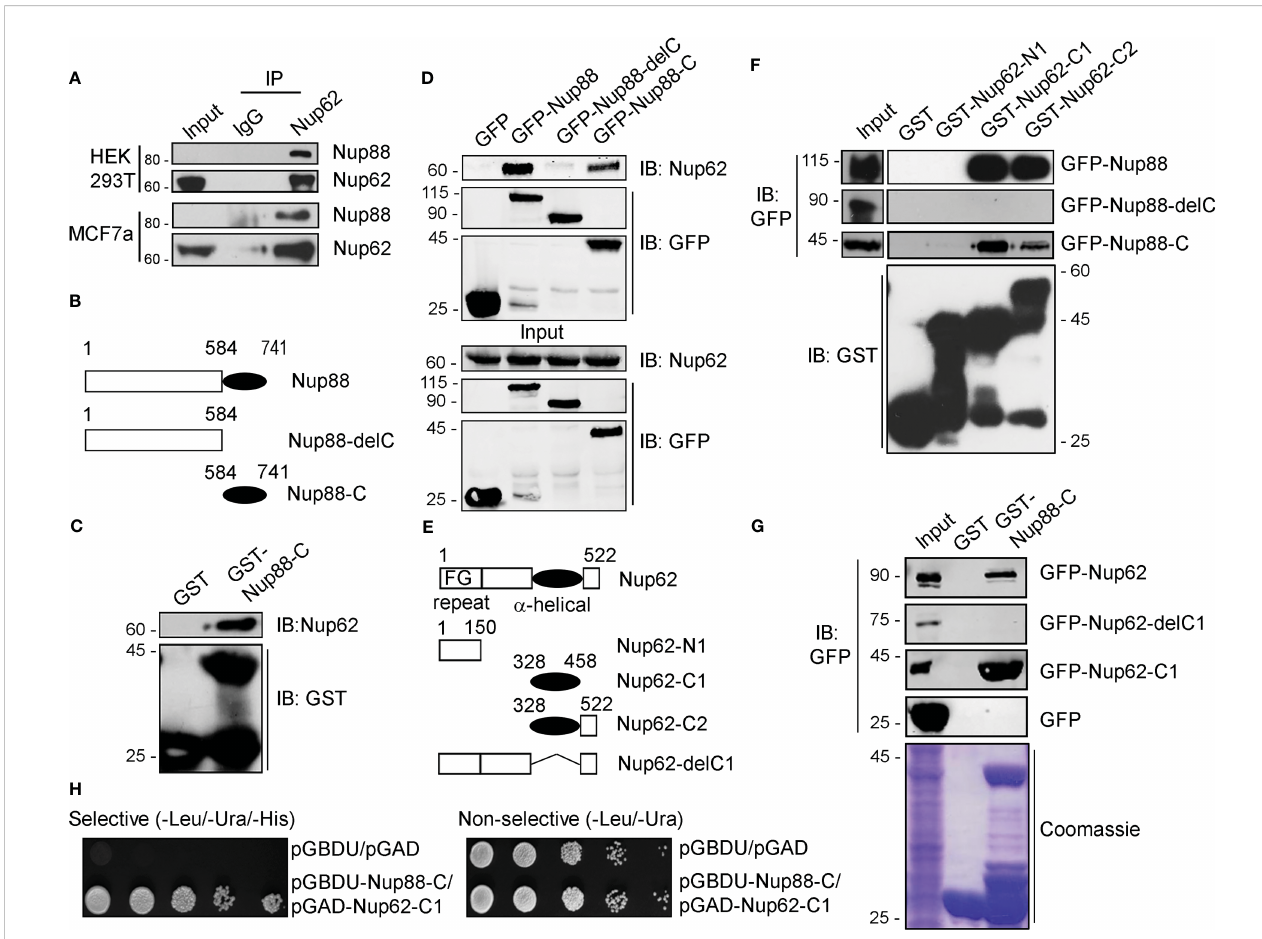
FIGURE 3 Nup88 and Nup62 interact through their carboxy-termini. (A) Anti-Nup62 antibody-mediated immunoprecipitation (IP) from HEK293T and MCF7 cell lysates and immunoblotting (IB) for indicated proteins. (B) Schematic representation of Nup88 domain constructs used in cellular transfection and GST and GFP binding protein (GBP) pulldown experiments. (C) Pull down of endogenous Nup62 on GST and GST-Nup88-C coated beads from HEK293T lysates and detection by indicated antibodies. (D) GBP pulldown from HEK293T lysates expressing either GFP-Nup88 or GFP-Nup88-delC or GFP- Nup88-C. Pulldown and input samples were probed with indicated antibodies. (E) Schematic representation of Nup62 constructs used in this study. (F) Beads coated with recombinant proteins indicated on top of the lanes used in pulldown experiments from HEK293T cell lysates expressing GFP-Nup88, or Nup88-delC or Nup88-C proteins. Pulldown samples and input fractions were immunoblotted with the indicated antibodies. (G) Pulldown from HEK293T cell lysate expressing GFP-Nup62, or Nup62-delC1 or Nup62-C1 or GFP on GST or GST-Nup88-C. Pulldown samples and input fractions were immunoblotted with the anti-GFP antibody. (H) Yeast two-hybrid interaction analysis using the DNA binding domain (pGBDU) construct of Nup88-C